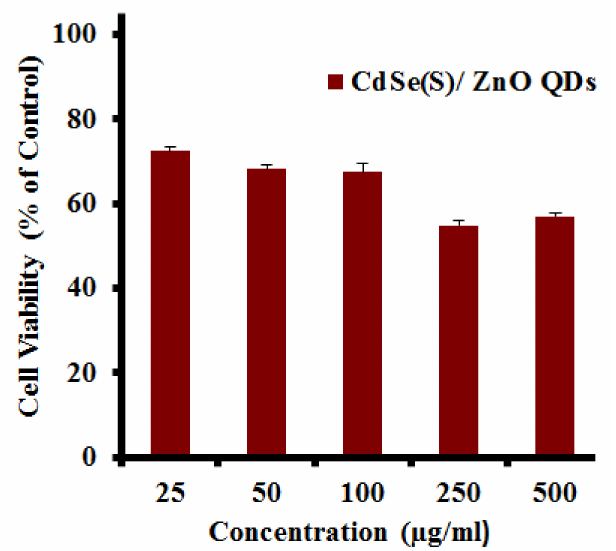
Figure 7. The results of cytotoxicity assays of CdSe(S)/ZnO core/shell QDs towards human colorectal carcinoma cells (HCT-116). Error bars indicate standard error of the mean and cell media without treatment with QDs was used as a control.